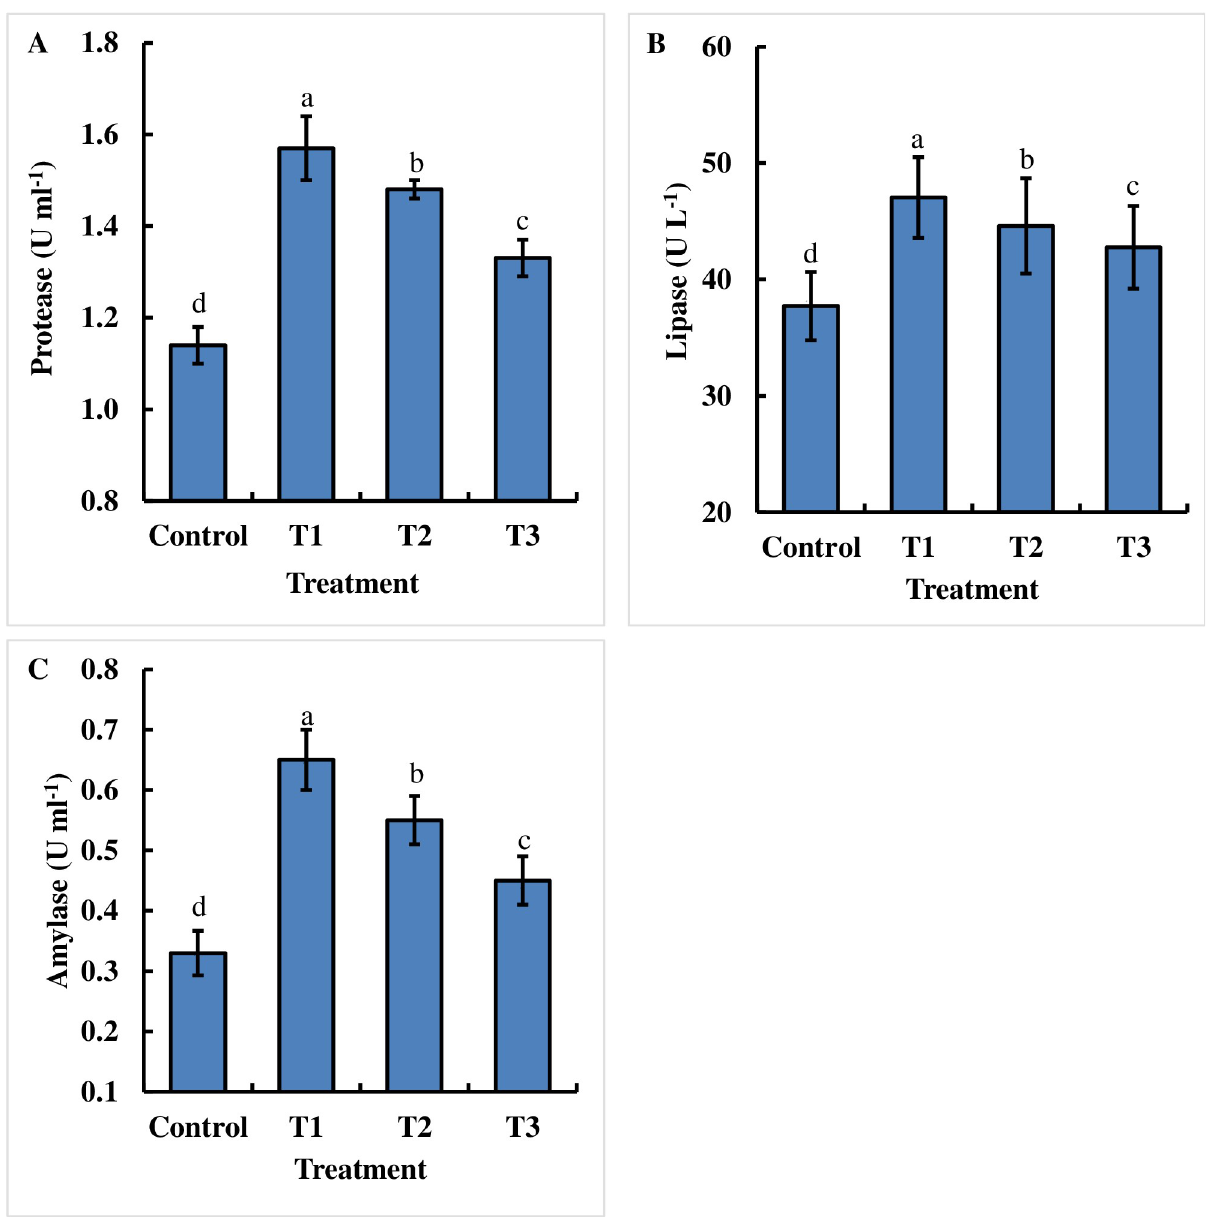
Fig 3. Assessment of the effects of dietary chitosan on the intestinal digestive enzymes (A, B and C) of fish. Fish were reared with three doses of dietary chitosan for 60 days. Here, Control = 0 g kg -1 feed; T1 = 1 g kg -1 feed; T2 = 2 g kg -1 feed and T3 = 3 g kg -1 feed. One-way ANOVA was performed to analyze the data of three replicate experiments, and the data in the columns varied significantly according to the least significant difference (LSD) at P < 0.05 (Statistix 10). Different letter bars indicate significant variations in (A) protease, (B) lipase, and (C) amylase levels of the fish in different dietary chitosan groups at P < 0.05 (Statistix 10). Error bar = ± SD; n =